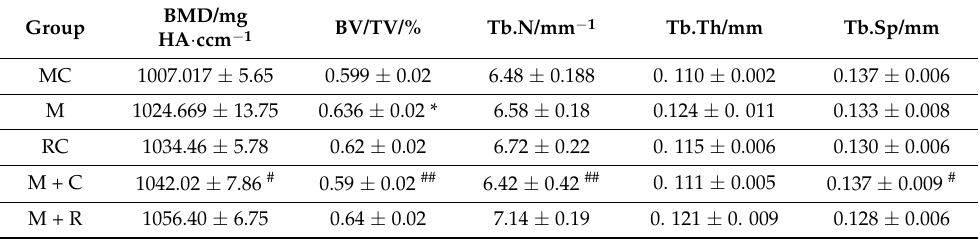
Table 5. Morphological changes of subchondral bone in the femoral condyle of knee joint.